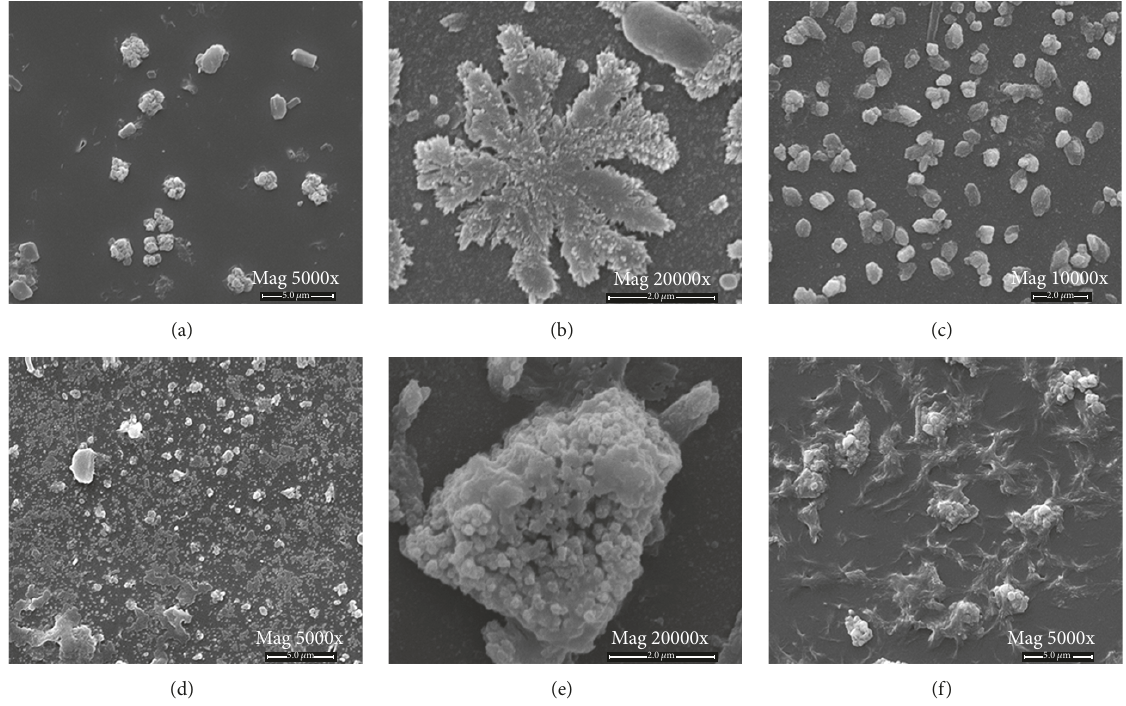
Figure 7: SEM images of HCPTNPs using gelatin as surfactants under different HP and amount conditions: (a) 0.5 mg, 600 bar; (b) 0.5 mg, 800 bar; (c) 0.5 mg, 1000bar; (d) 2.5 mg, 600 bar; (e) 2.5 mg, 800 bar; (f) 2.5 mg,